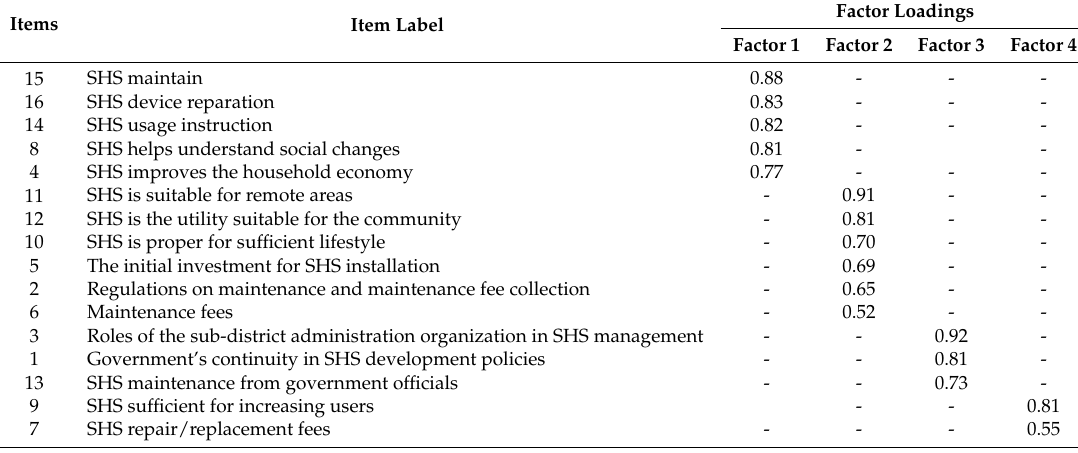
Table 5. Factor structure of the sustainable SHS development factor weights after varimax